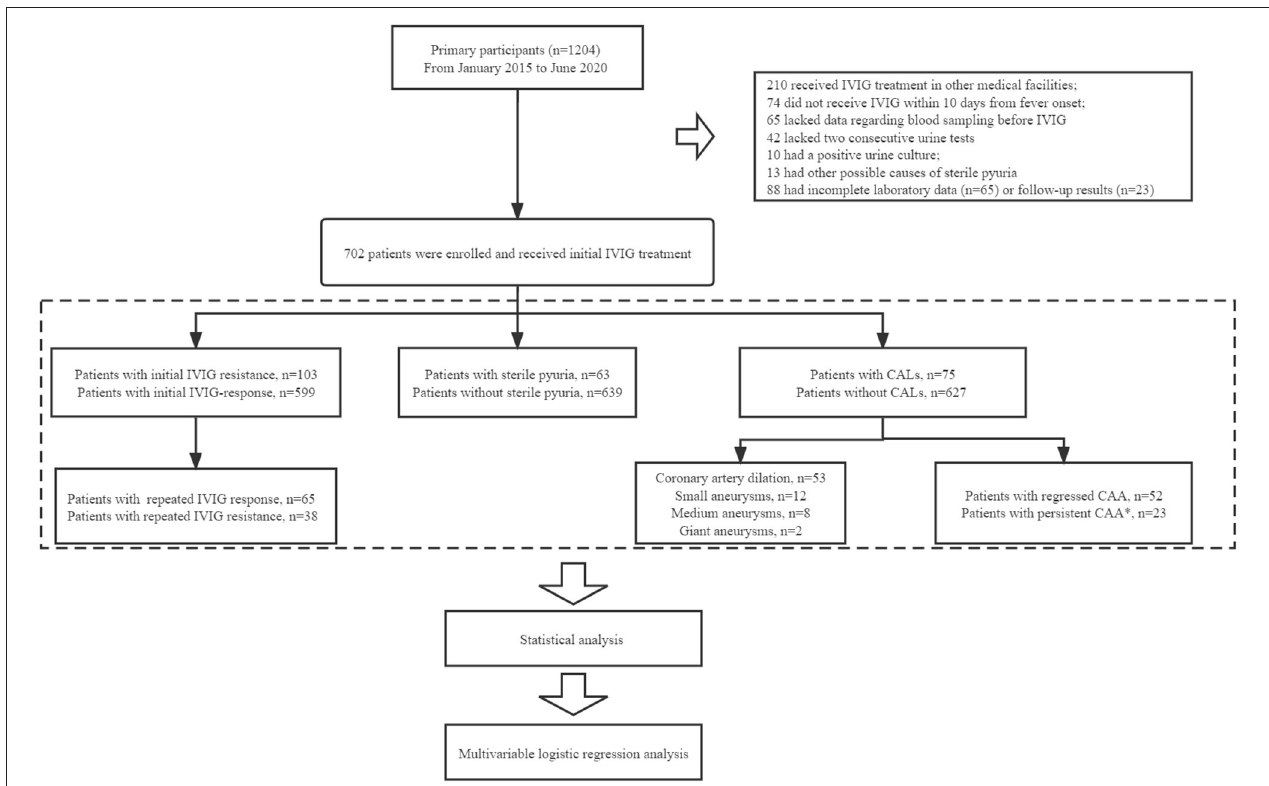
FIGURE 1 | The flowchart of our prospective cohort study. In total, 1,204 patients were diagnosed with KD on admission. Patients who had received IVIG infusion at other medical facilities ( n = 210), who did not receive IVIG treatment within 10 days after the onset of fever ( n = 74), and who either did not undergo blood sampling ( n = 65) or two consecutive urine tests ( n = 42) before IVIG administration, were excluded. Patients with a positive urine culture ( n = 10) or other possible causes of sterile pyuria ( n = 13) were excluded. We excluded patients with incomplete laboratory data ( n = 65) or follow-up results ( n = 23). Finally, a total of 702 patients with KD were enrolled for analysis. All patients with KD were divided into different groups: IVIG resistance ( n = 103), sterile pyuria ( n = 63), CALs ( n = 75). Of the 75 KD children with CALs, CAD, small CAAs, moderate CAAs, and giant CAAs were observed in 53, 12, 8, and 2 patients, respectively. Patients with CALs were further divided into the persistent CALs group ( n = 23) and the regressed CALs group ( n = 52). *Patients who still had echocardiographic evidence of CAA after 1-year follow-up beyond KD